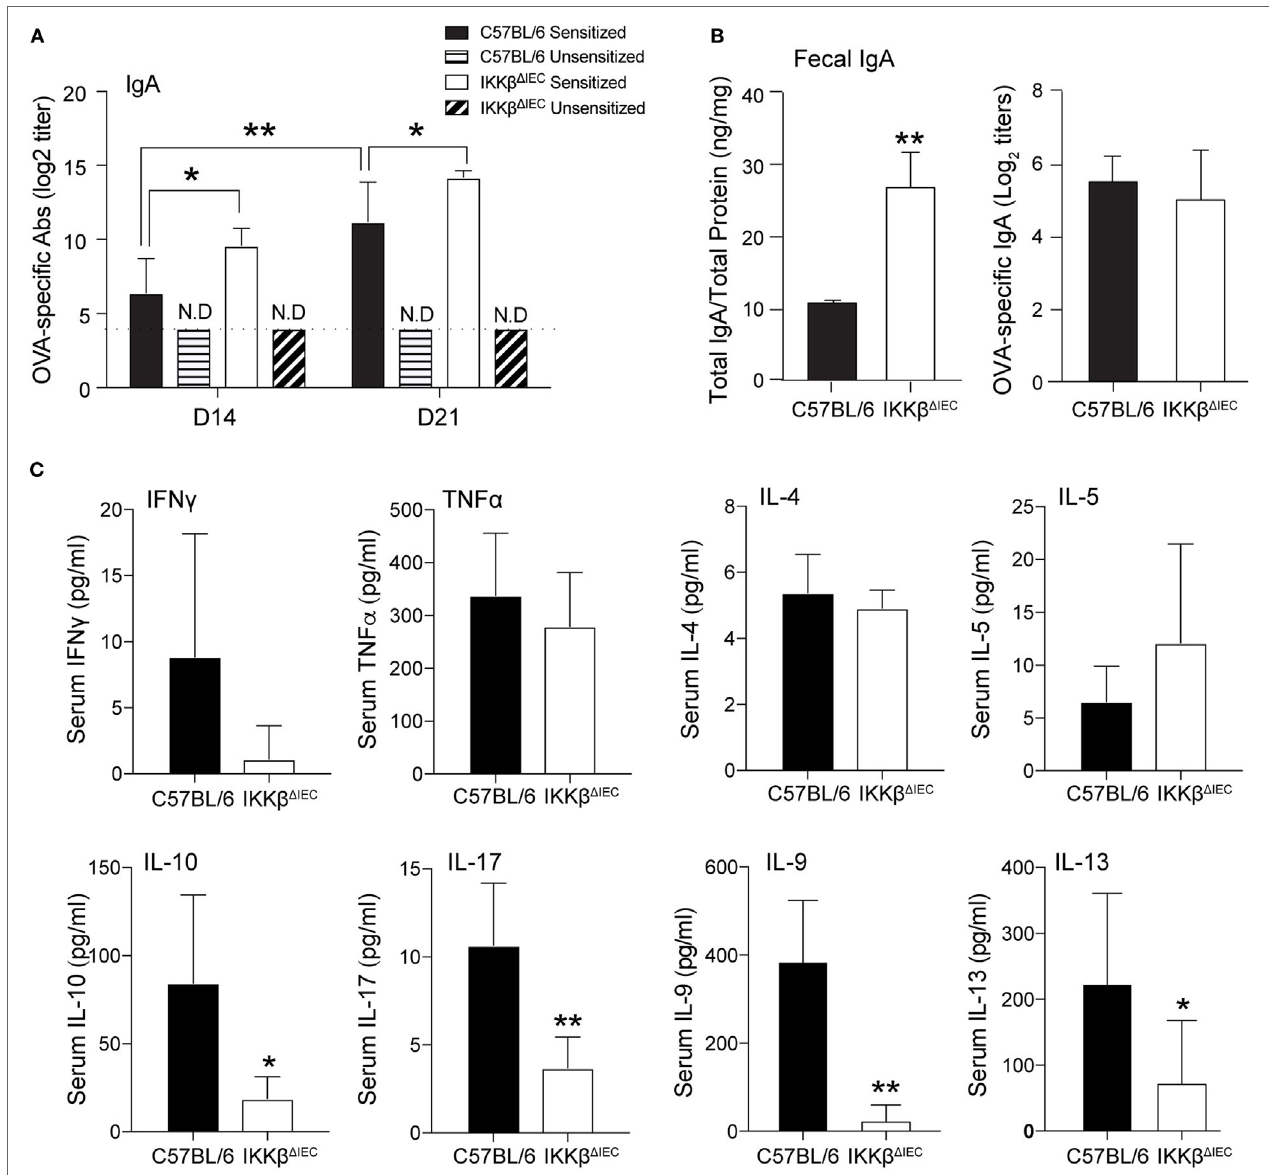
FigUre 2 | Allergen-specific secretory IgA (SIgA) and serum cytokine responses of IKK β Δ IEC mice after oral sensitization and oral allergen challenge. (a) Allergen- specific serum IgA. (B) Total and allergen-specific SIgA in fecal extracts. Mice were sensitized by oral administration of ovalbumin (OVA) (1 mg) and cholera toxin (15 µg). Serum were collected on days 14 and 21, and fecal samples were collected on day 30. Total and OVA-specific IgA were assessed by enzyme-linked immunosorbent assay. (c) Serum cytokines. Serum samples were collected 2 h after allergen challenge on day 30, and the concentrations of cytokines were evaluated by a multiplex assay. Data are expressed as mean ± SD. * p < 0.05; ** p < 0.01 and are from at least five experiments and five